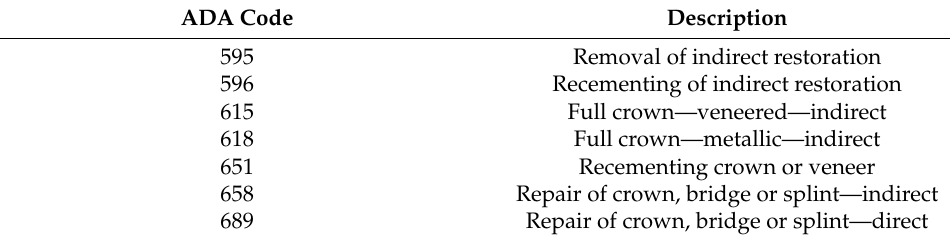
Table 1. ADA codes charted as part of patient